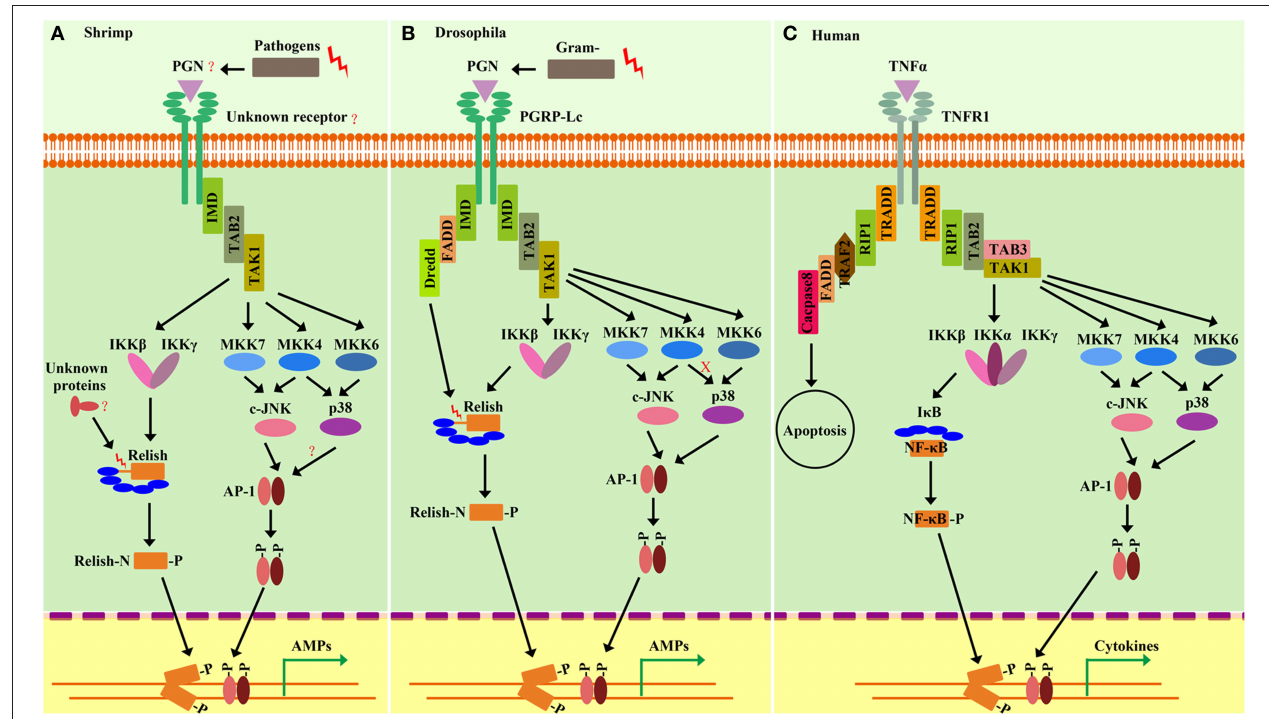
FIGURE 4 | Comparison of the shrimp IMD pathways (A) and Drosophila IMD pathways (B) and Human TNFR signaling (C) . Homologies between signaling components are depicted by similar shapes and colors. Shrimp and Drosophila IMD pathway-signaling events resemble the Human tumor necrosis factor receptor (TNFR) signaling pathway. In shrimp, some pivotal components of the IMD pathway, such as the receptors, DREDD, and FADD, are still unknown. Similar to Drosophila , pathogen challenges can initiate intracellular signaling events involving IMD, TAB2, and TAK1, which in turn induce the activation of MAPK-AP-1 and IKK-Relish branches. The activation of Relish is required to be phosphorylated by the IKK complex and is cleaved by unknown factors in shrimp. In the MAPK-AP-1 branch of shrimp IMD pathways, the signaling cascade is more similar to that of Human than that of Drosophila , as manifested by the finding that shrimp p38 can be phosphorylated by MKK4, but Drosophila p38 cannot. In shrimp, activation of both of the two branches of IMD pathways can induce the expression of AMPs that confer protection from Gram-negative and Gram-positive bacterial